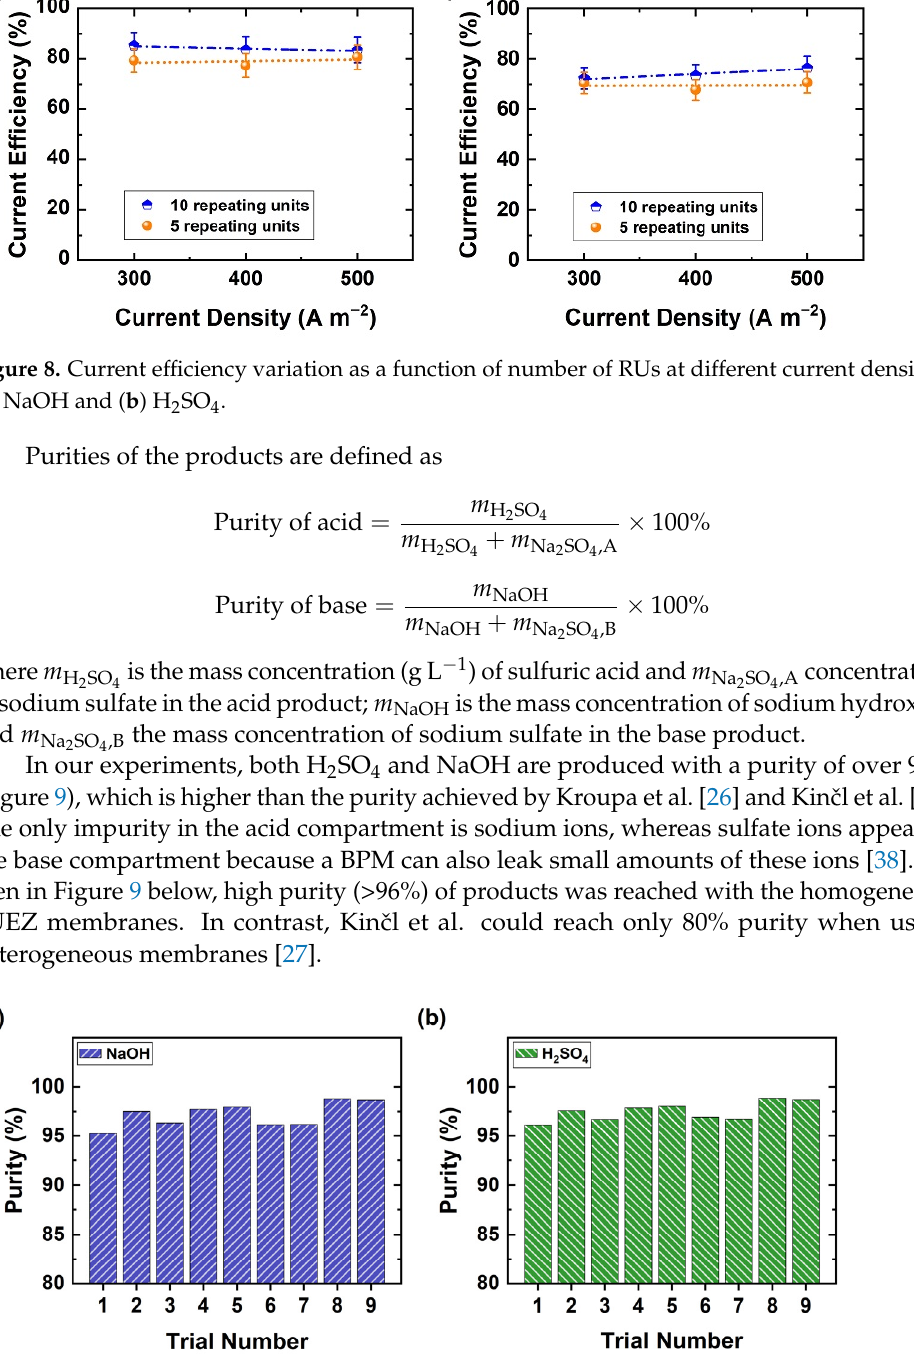
Figure 9. BPED of the effluent; purity of products ( a ) NaOH and ( b ) H 2 SO 4 .